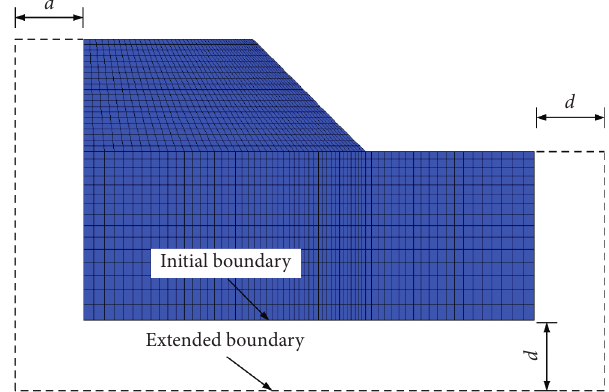
Figure 8: The schematic of extended boundaries.